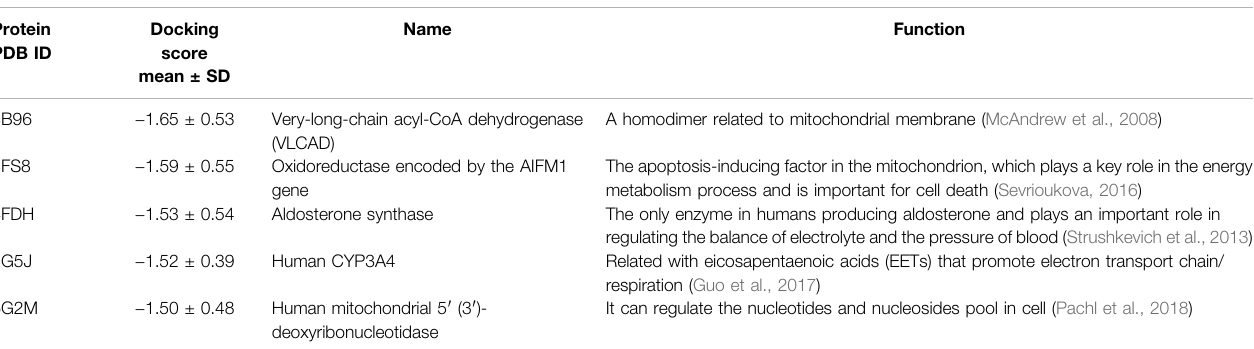
TABLE 3 | Functions of the protein with the lowest binding score for kinase inhibitor (KI)